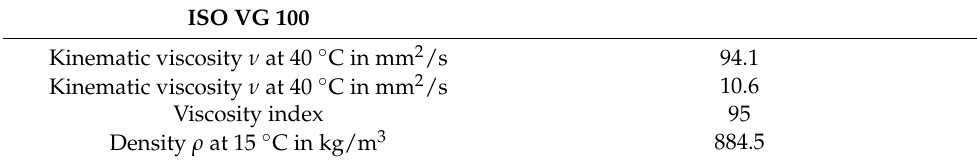
Table 4. Main properties of the oil